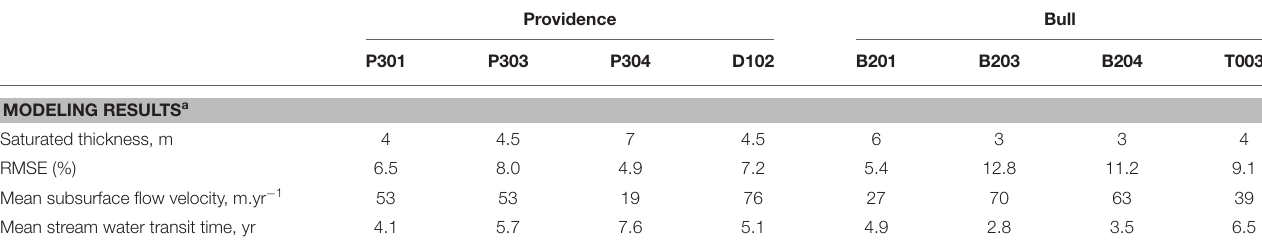
TABLE 3 | Modeling results for the eight